Question: Identify the chart type used in this figure.
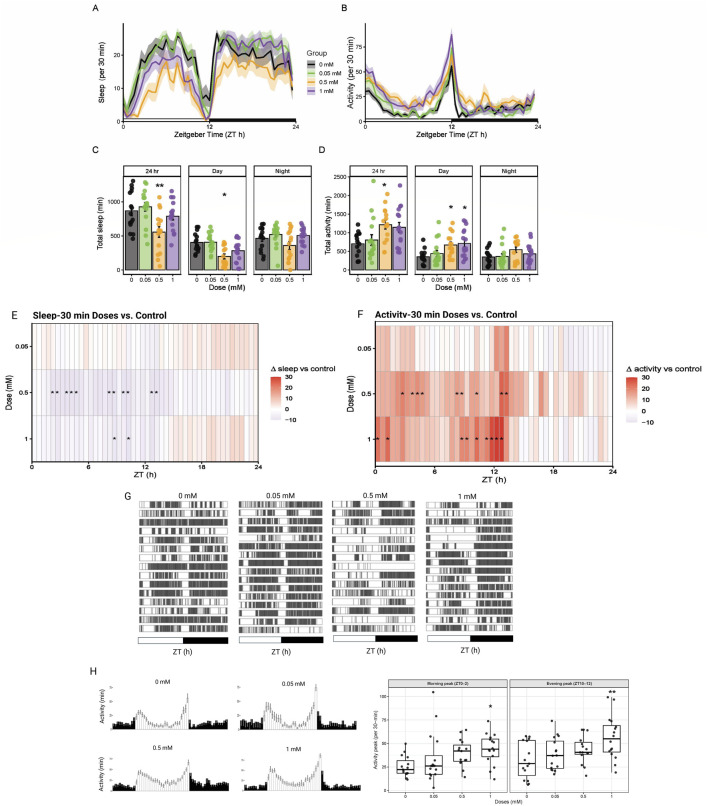
Answer: heatmap